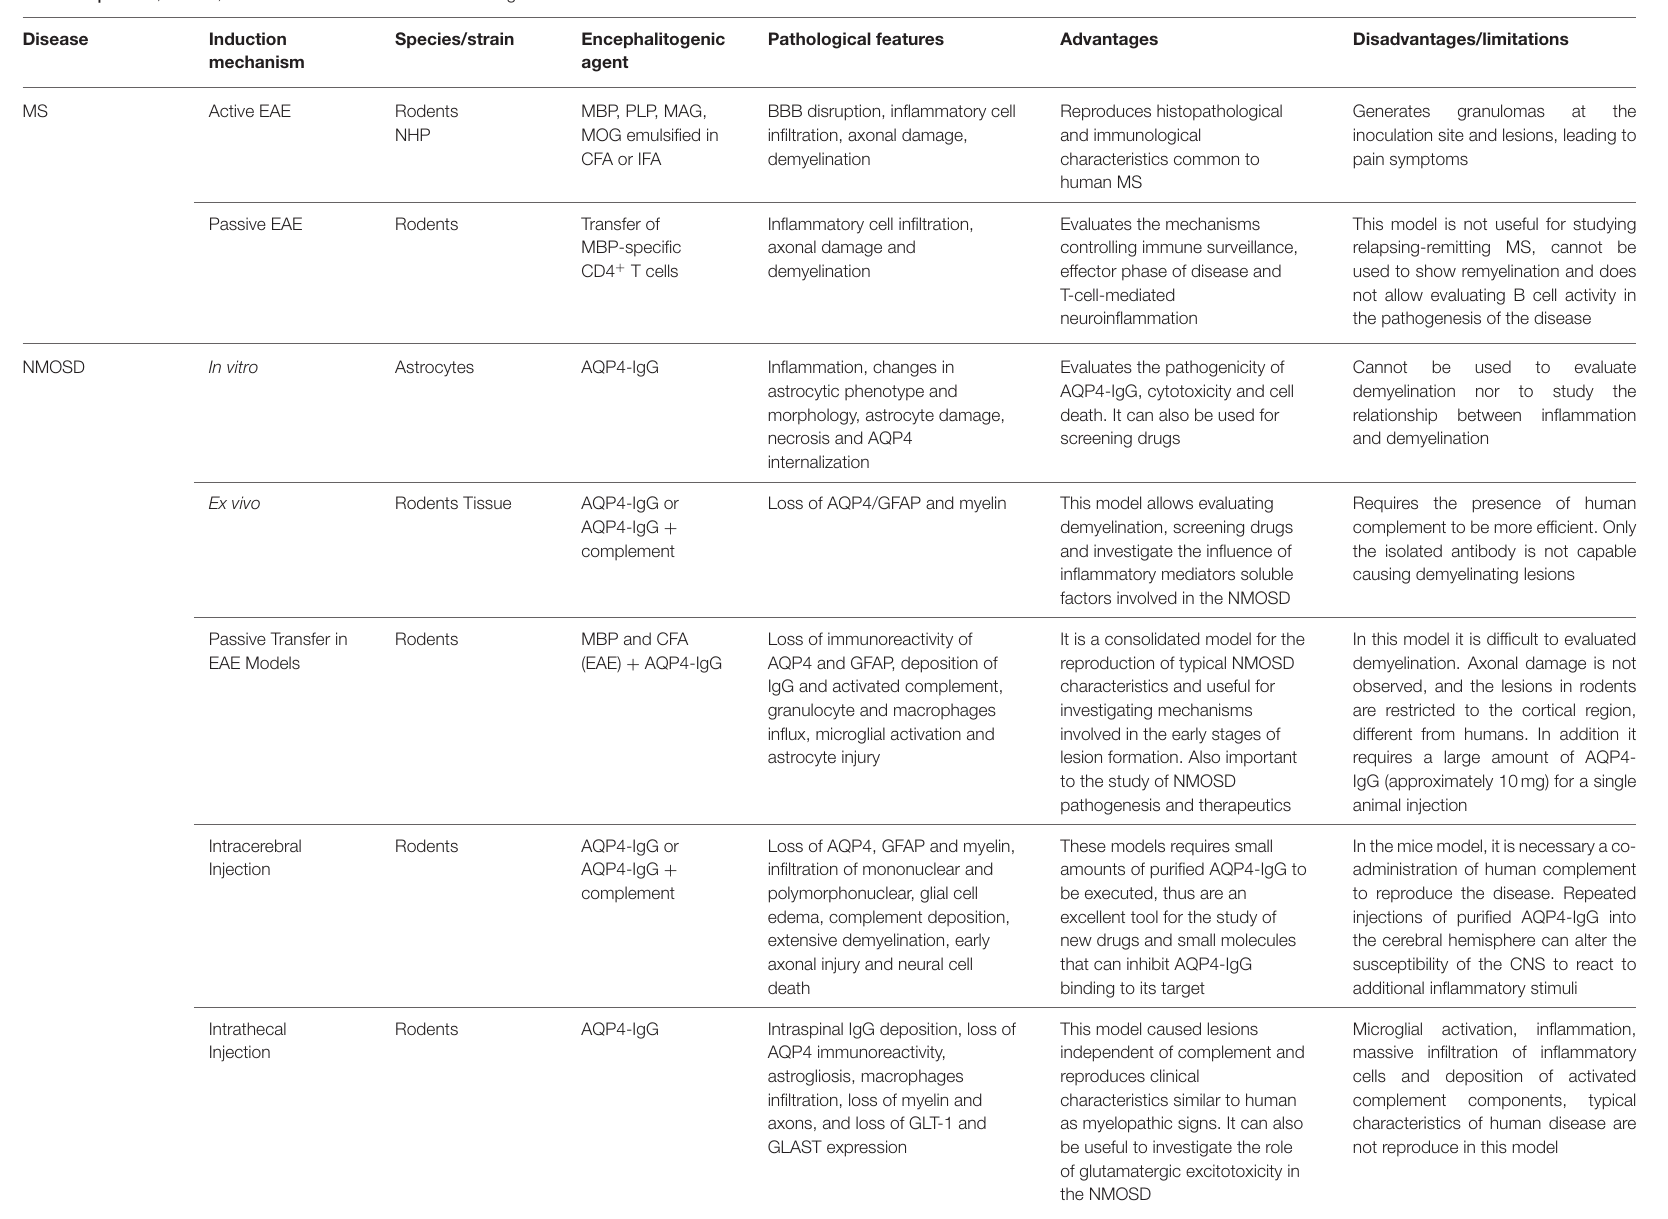
TABLE 1 | In vitro , ex vivo , and in vivo models of neuroimmunological